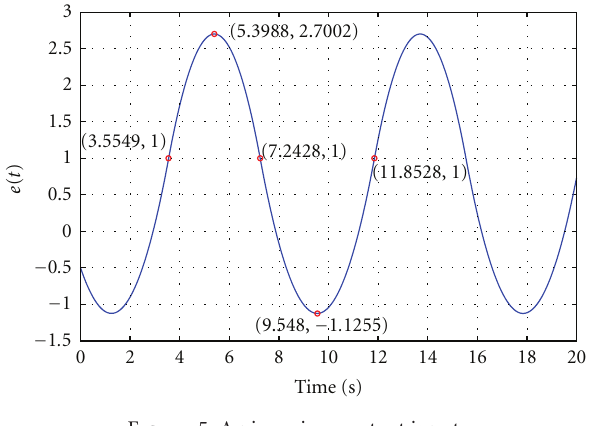
Figure 5: A piecewise constant input. Table 1: Limit cycle characteristics of Example